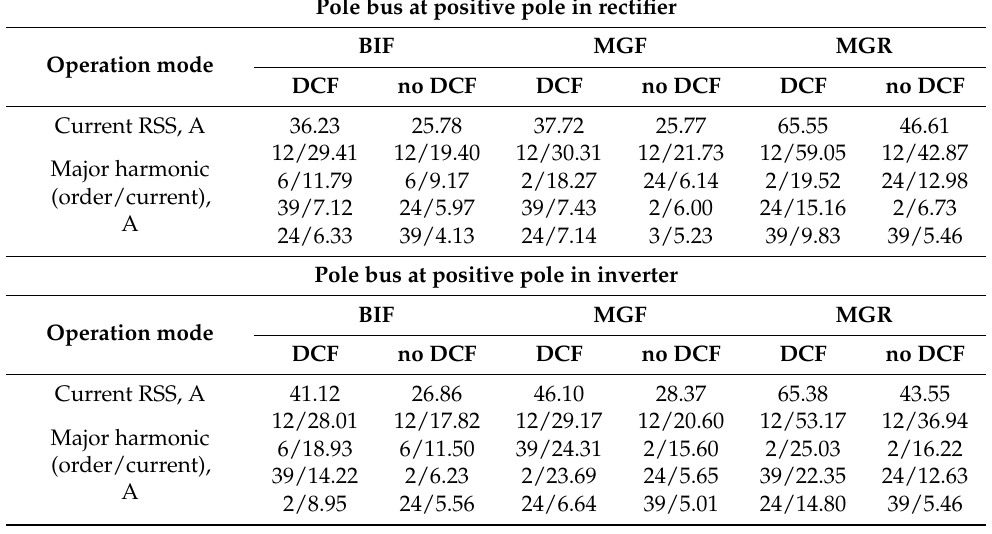
Table 6. Harmonic current stress for the SR. Pole bus at positive pole in